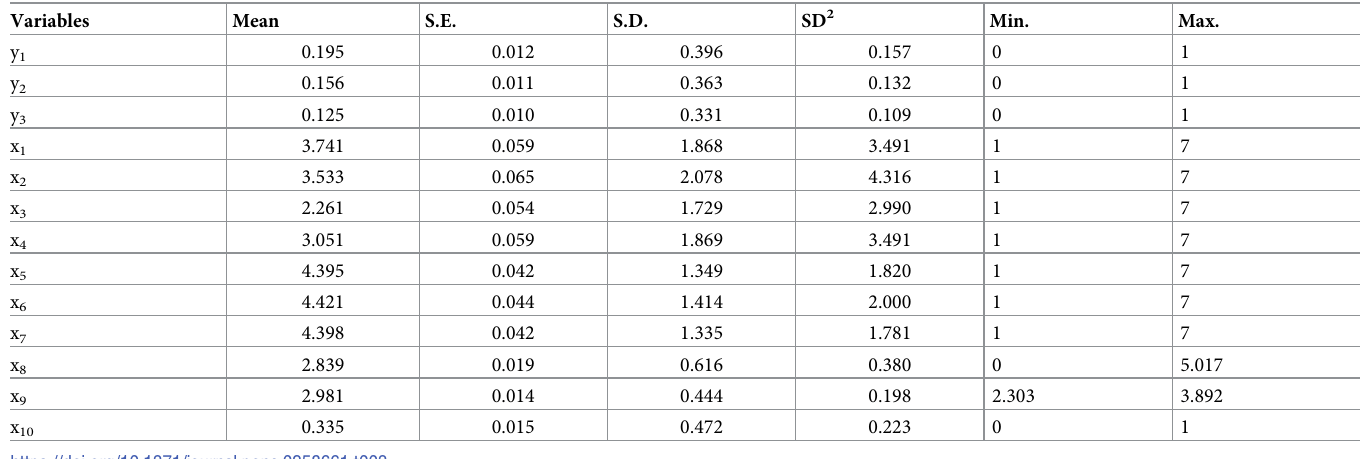
Table 3. Descriptive statistics of